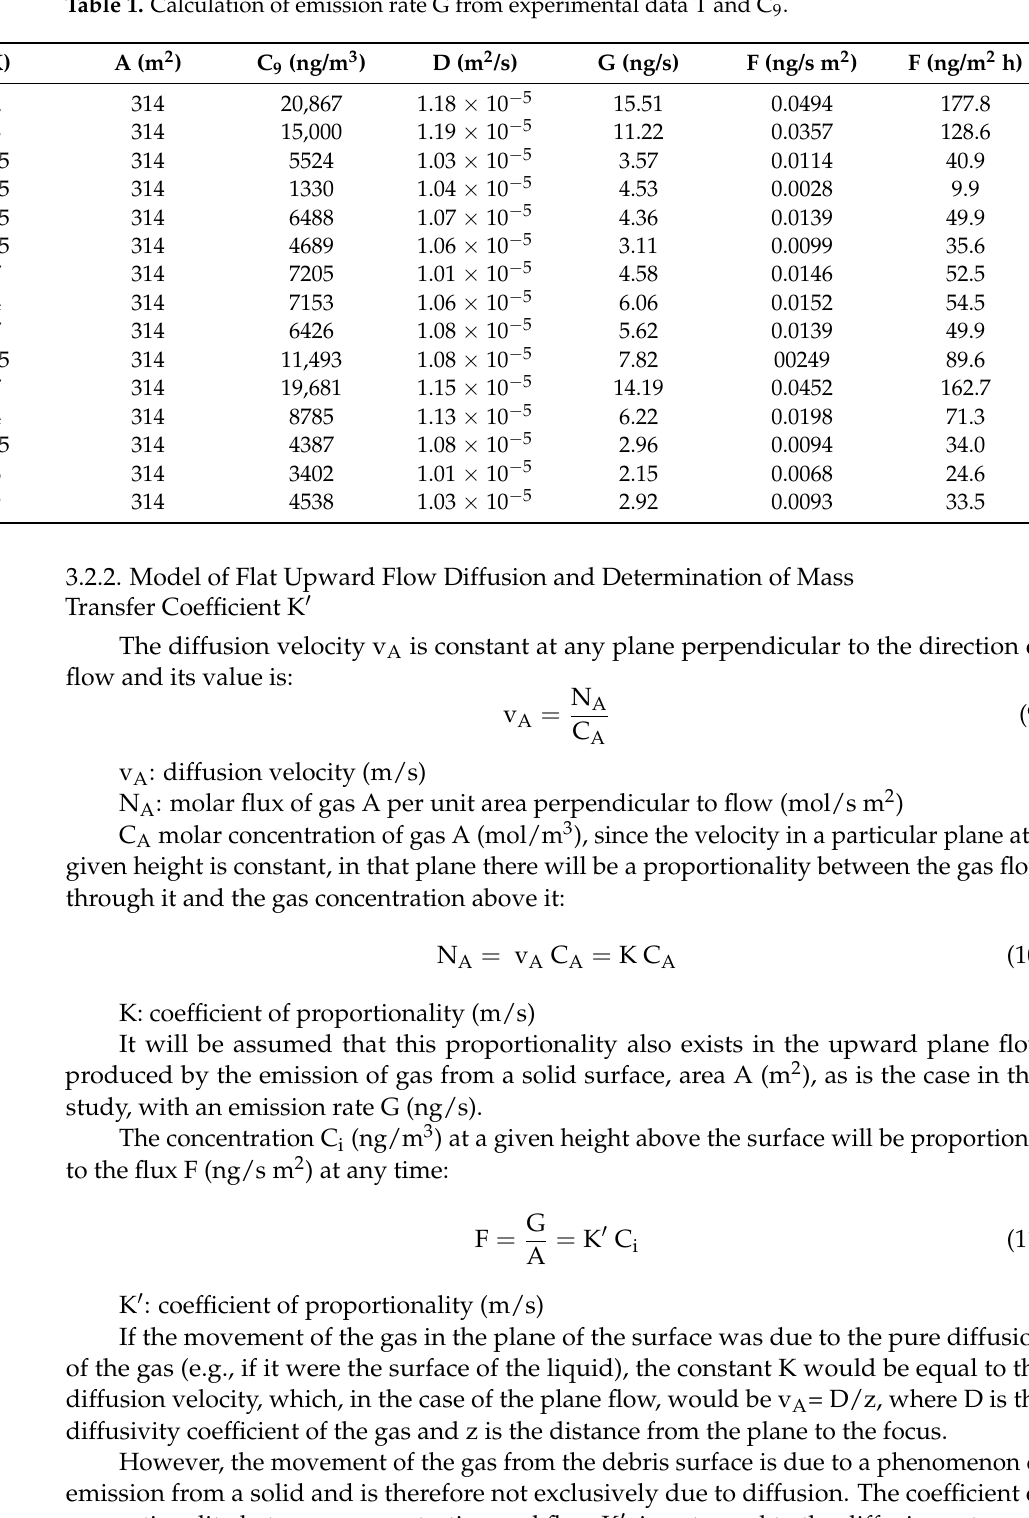
Table 1. Calculation of emission rate G from experimental data T and C 9